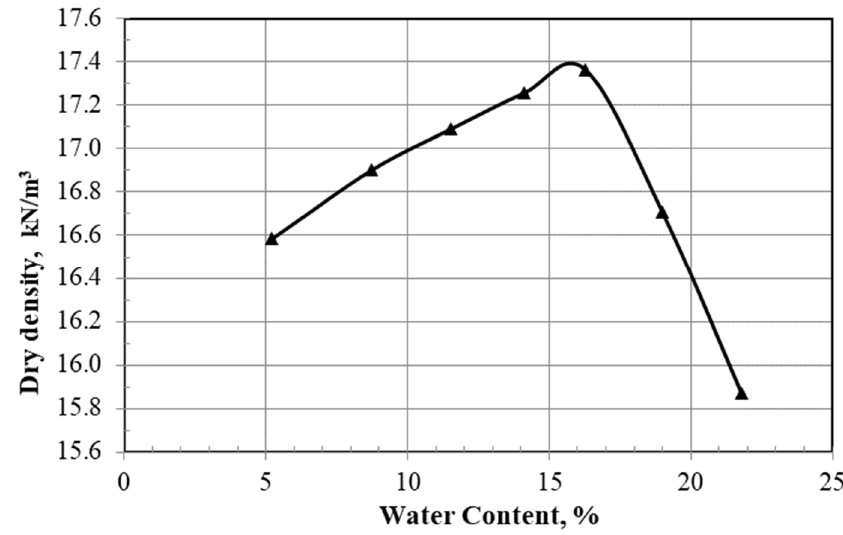
Figure 2. Compaction curve of sand-bentonite mixture.